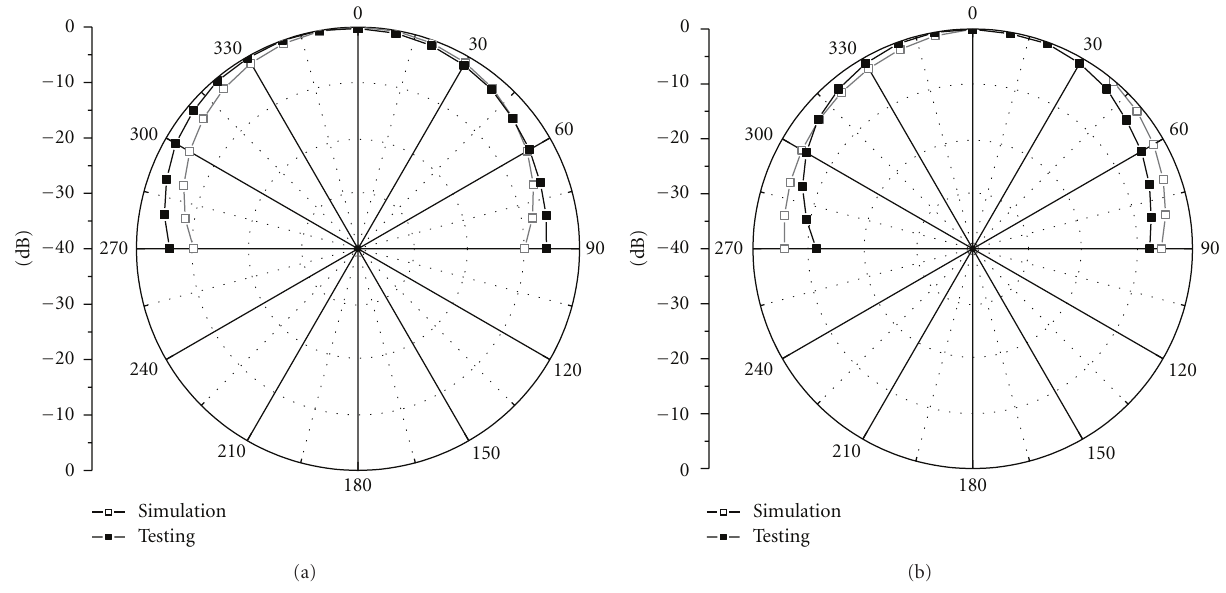
Figure 10: Radiation patterns of the open stub feed PIFA antenna: (a) E plane, (b) H